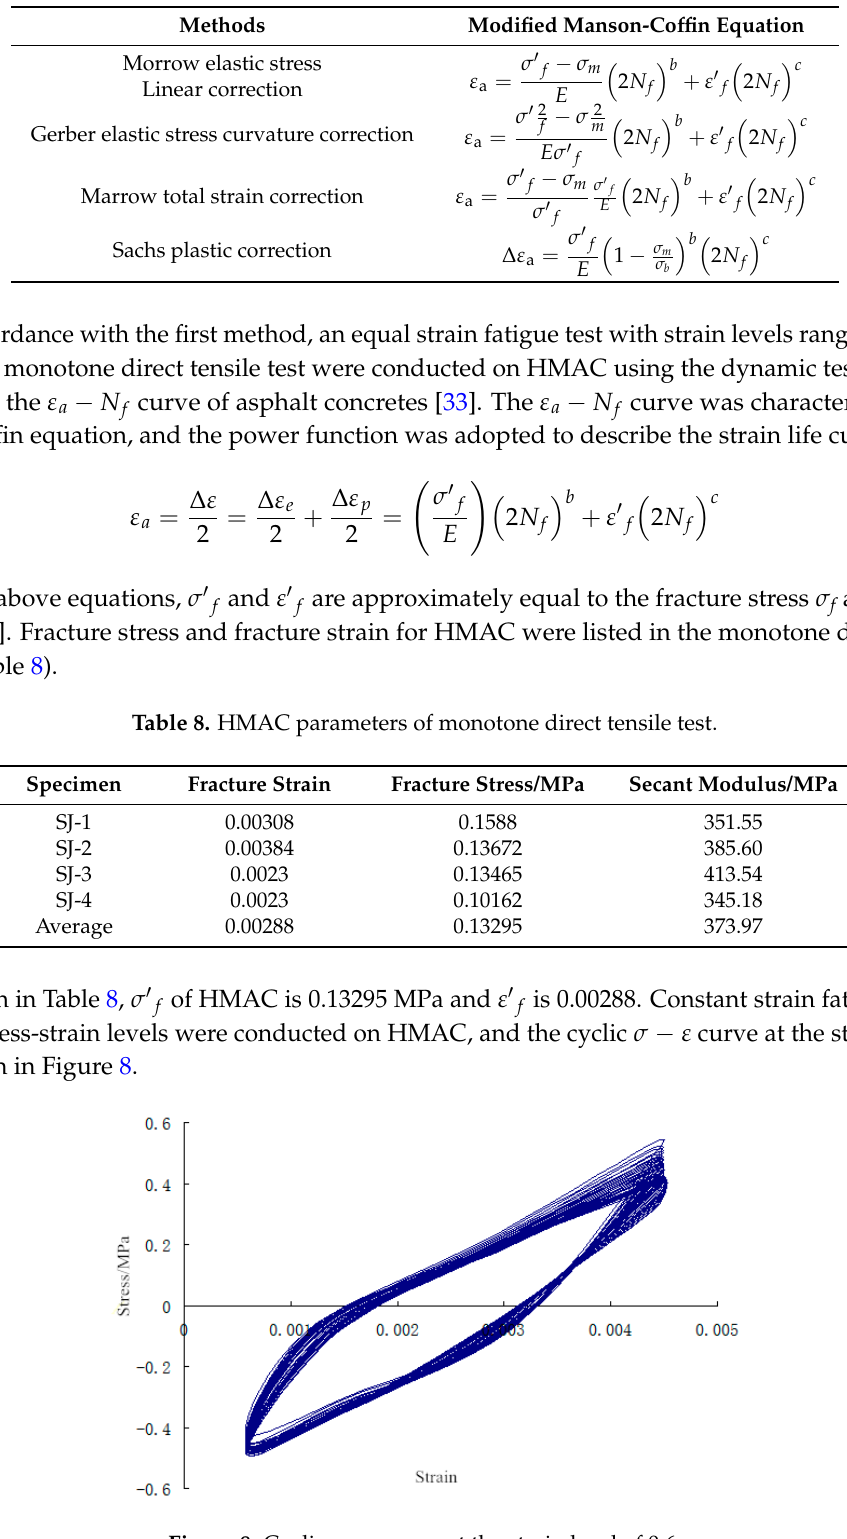
Figure 8. Cyclic σ − ε curve at the strain level of Figure 8. Cyclic εσ− curve at the strain level of 0.6.